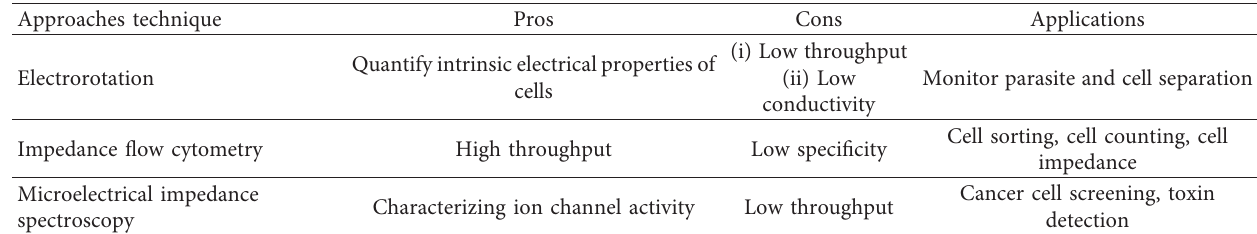
Table 6: Single-cell analysis by microfluidic